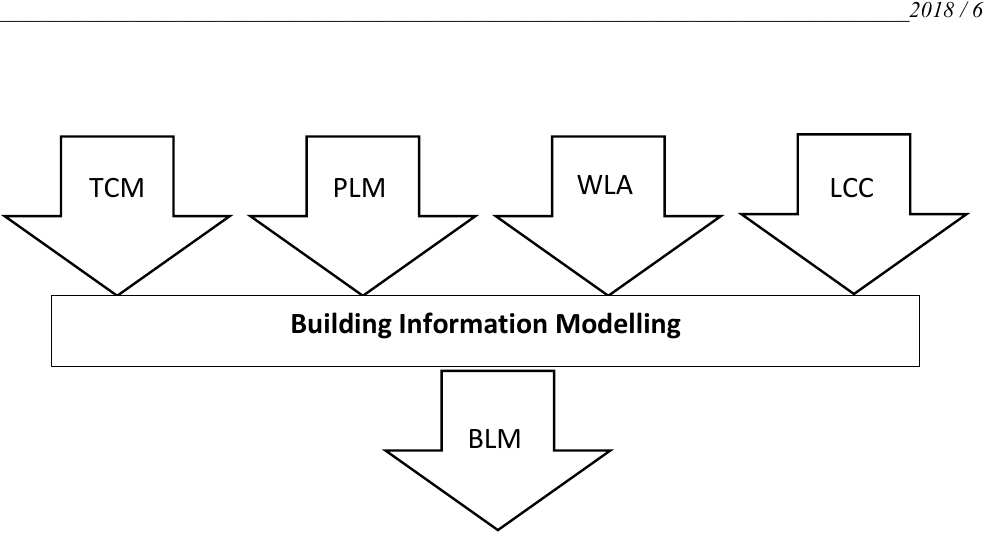
Fig. 1. Formation of building lifecycle management methodology (developed by the